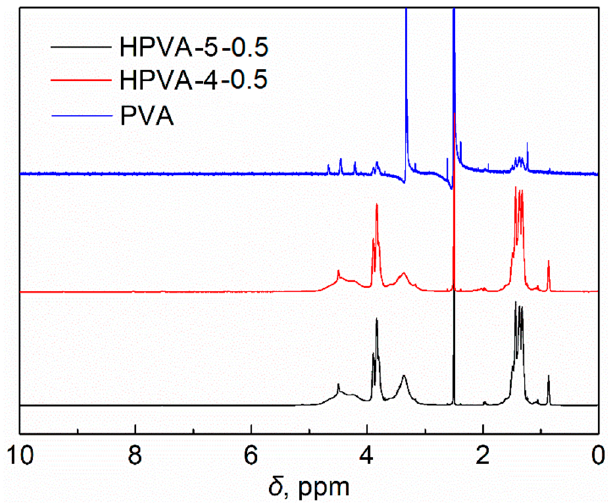
Figure 3. 1 H-NMR (DMSO-d 6 as solvent) spectra of the PVA, HPVA-5, and HPVA-4 samples.